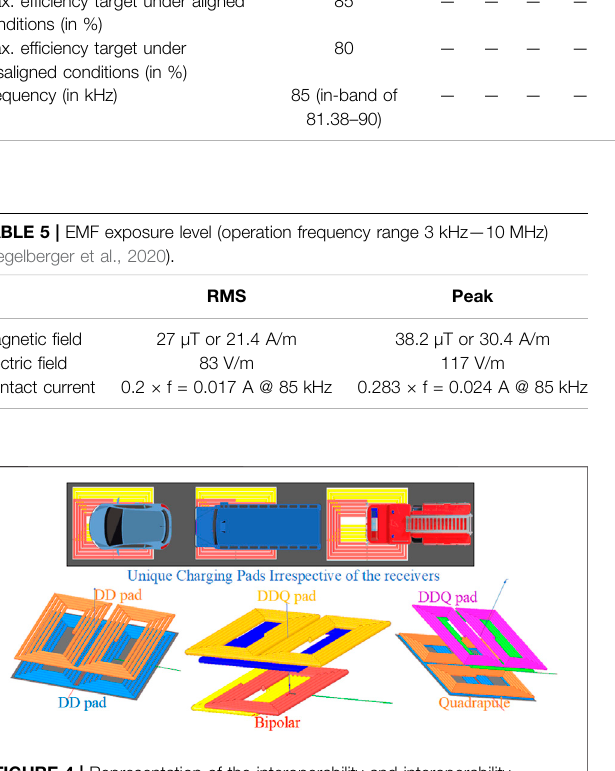
FIGURE 4 | Representation of the interoperability and interoperability coils (DD – DD, quadrapule-DDQ, bipolar-DDQ).